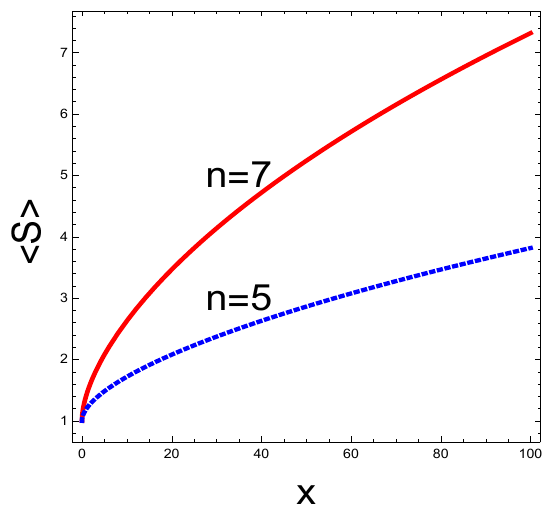
Figure 3 . Sommerfeld enhancement factor for the quintuplet and septuplet as the function of x ( M=T